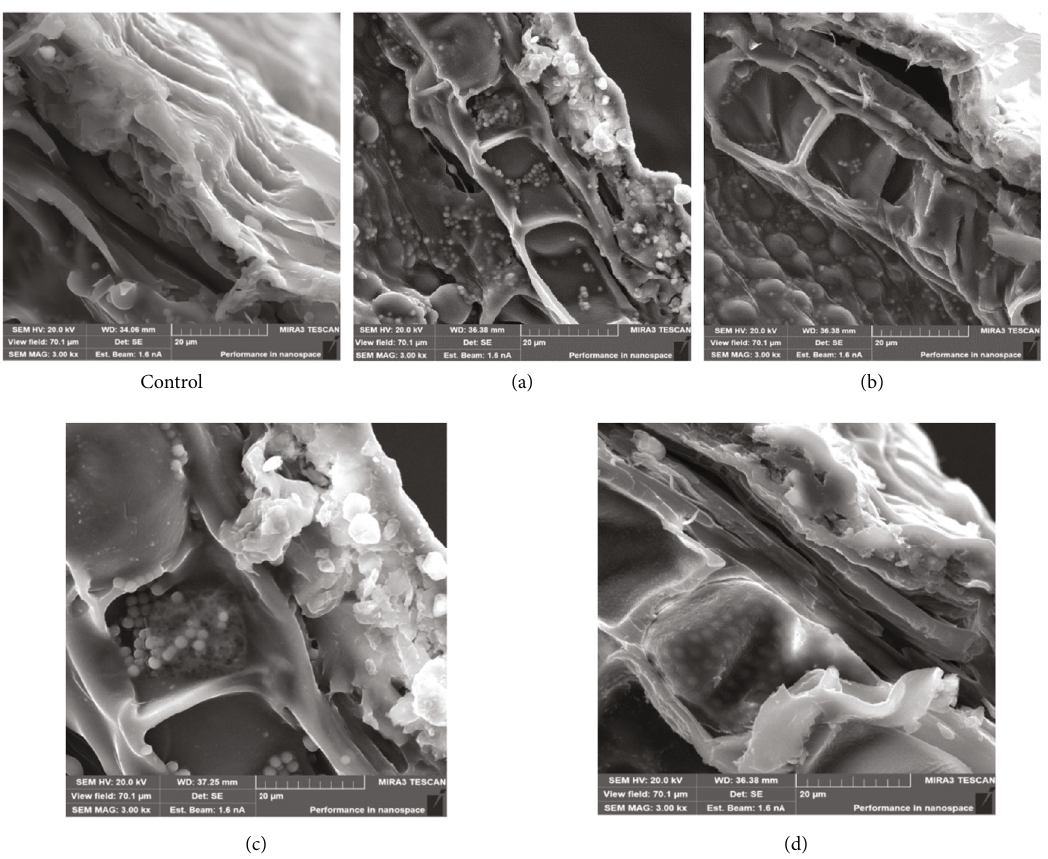
Figure 2: Characteristic view of electronic microphotographs of the cross-section of the control and experimental (a – d) wheat grain samples (Sample 1) after 8 hours of soaking, TESCAN MIRA3 SEM, magni fi cation